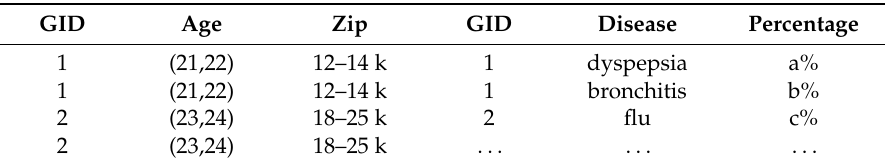
Table 6. Quasi identifier attributes and the result